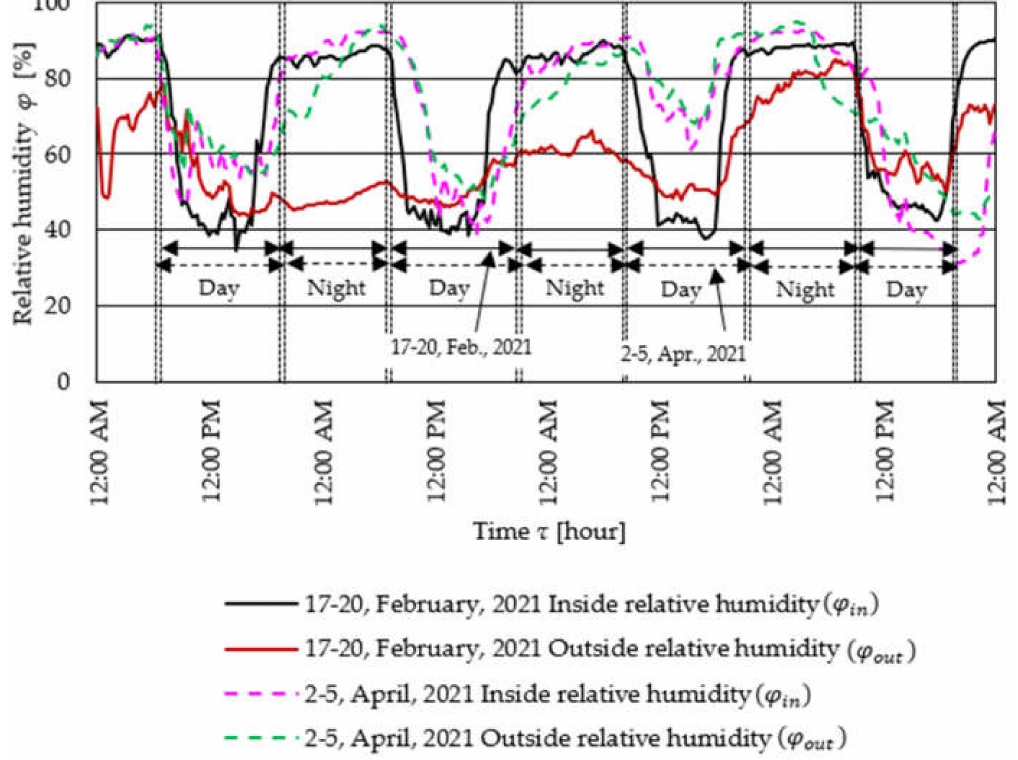
Figure 7. The comparison of relative humidity inside and outside the greenhouse at different